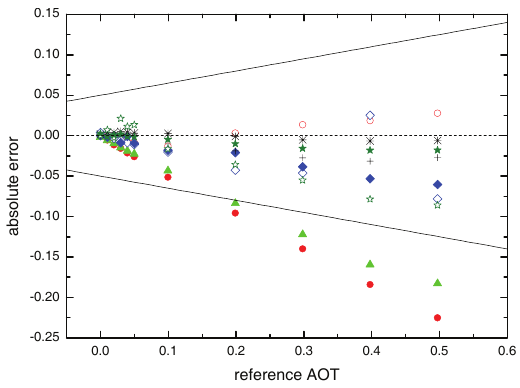
Fig. 12. The same as in Fig. 11 except for a smaller range of τ .